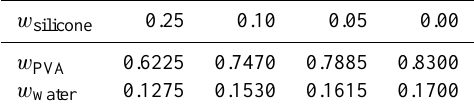
Table 4. Composition (mass fractions) of the investigated PVA/silicone composite matrices at 298.15K and 90% RH.